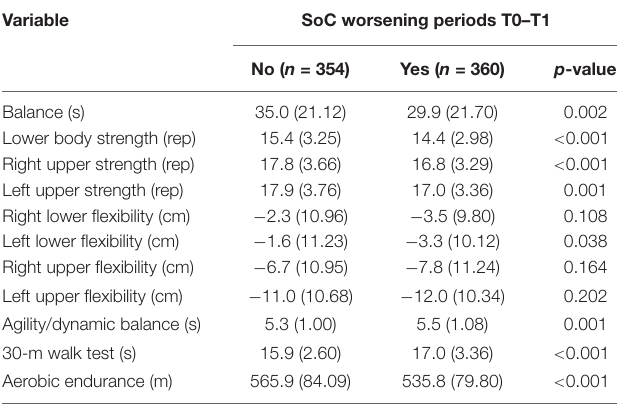
TABLE 5 | Physical fitness and SoC worsening between periods T0 and T1: Bivariate analysis.